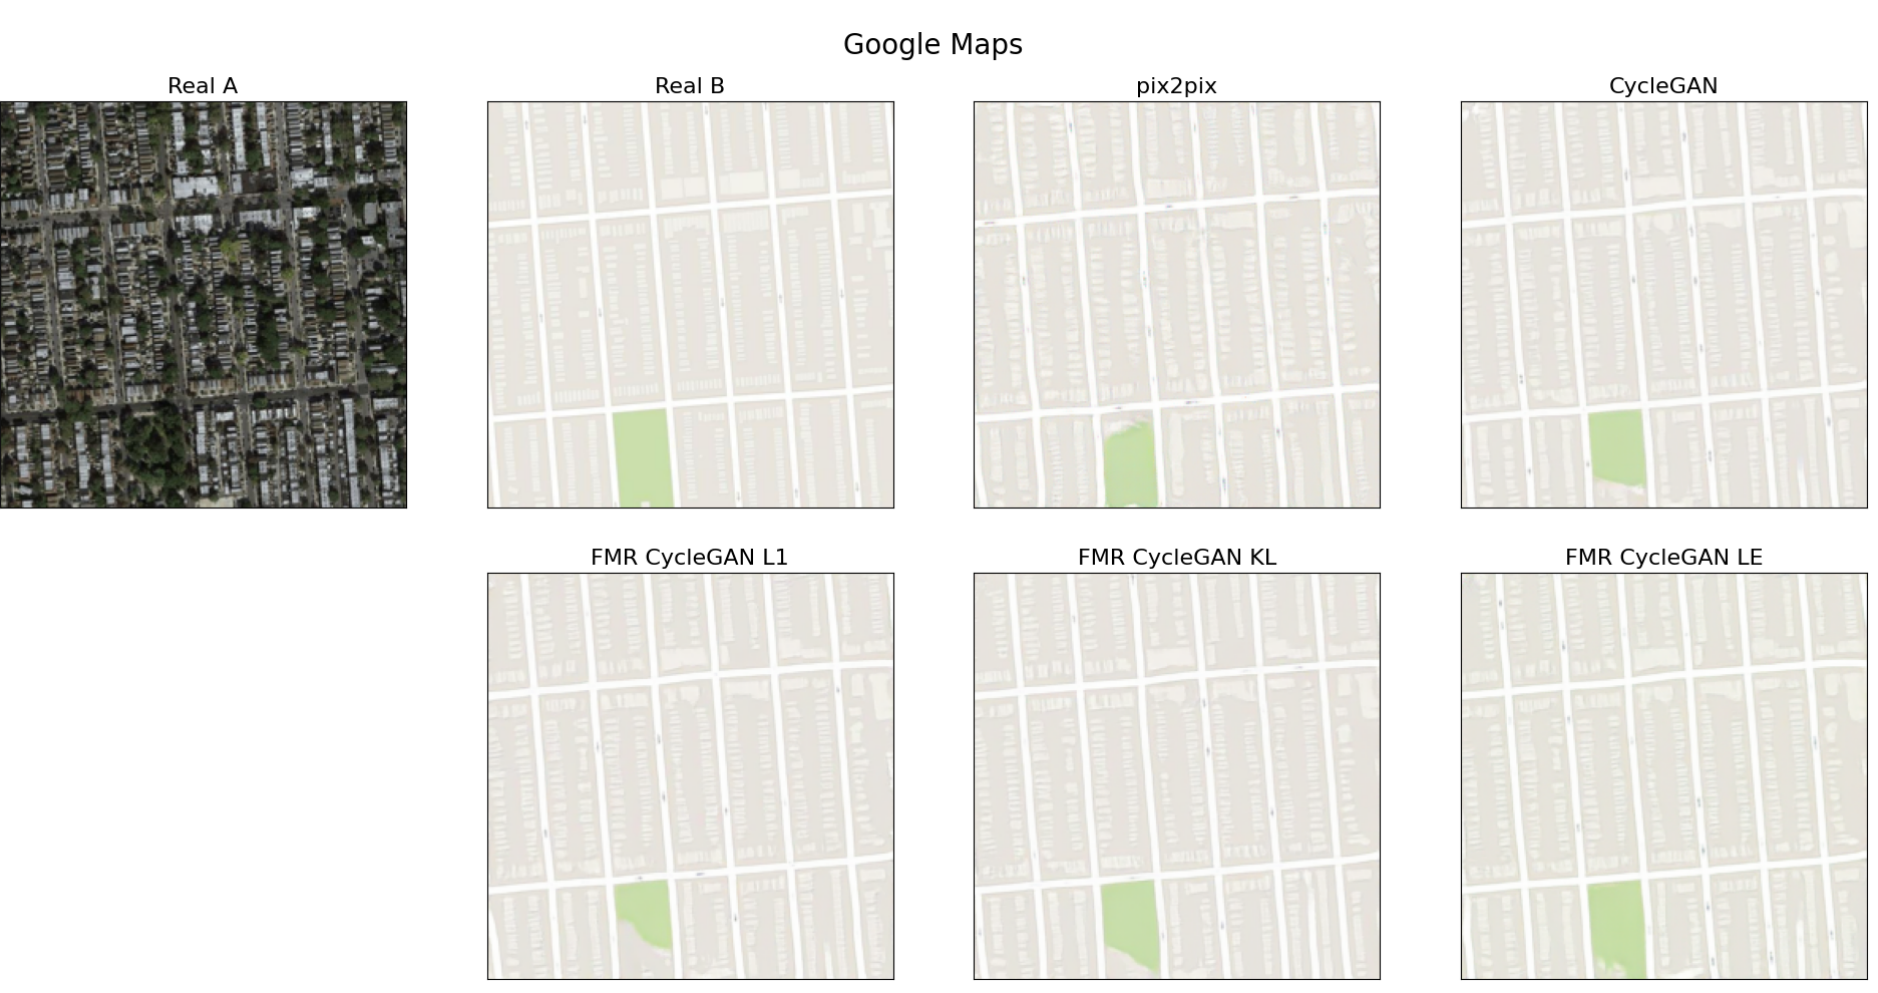
Figure 2. Visual comparison on the first example of paired images from the Google Maps aerial2map task (denoted as “Real A”, belonging to the source or “left” domain, and “Real B”, belonging to the target or “right” domain). The Proposed FMR CycleGAN with various ground distances (L1 corresponding to (8), KL corresponding to (10), and LE corresponding to (12)) was compared against the baseline CycleGAN and pix2pix